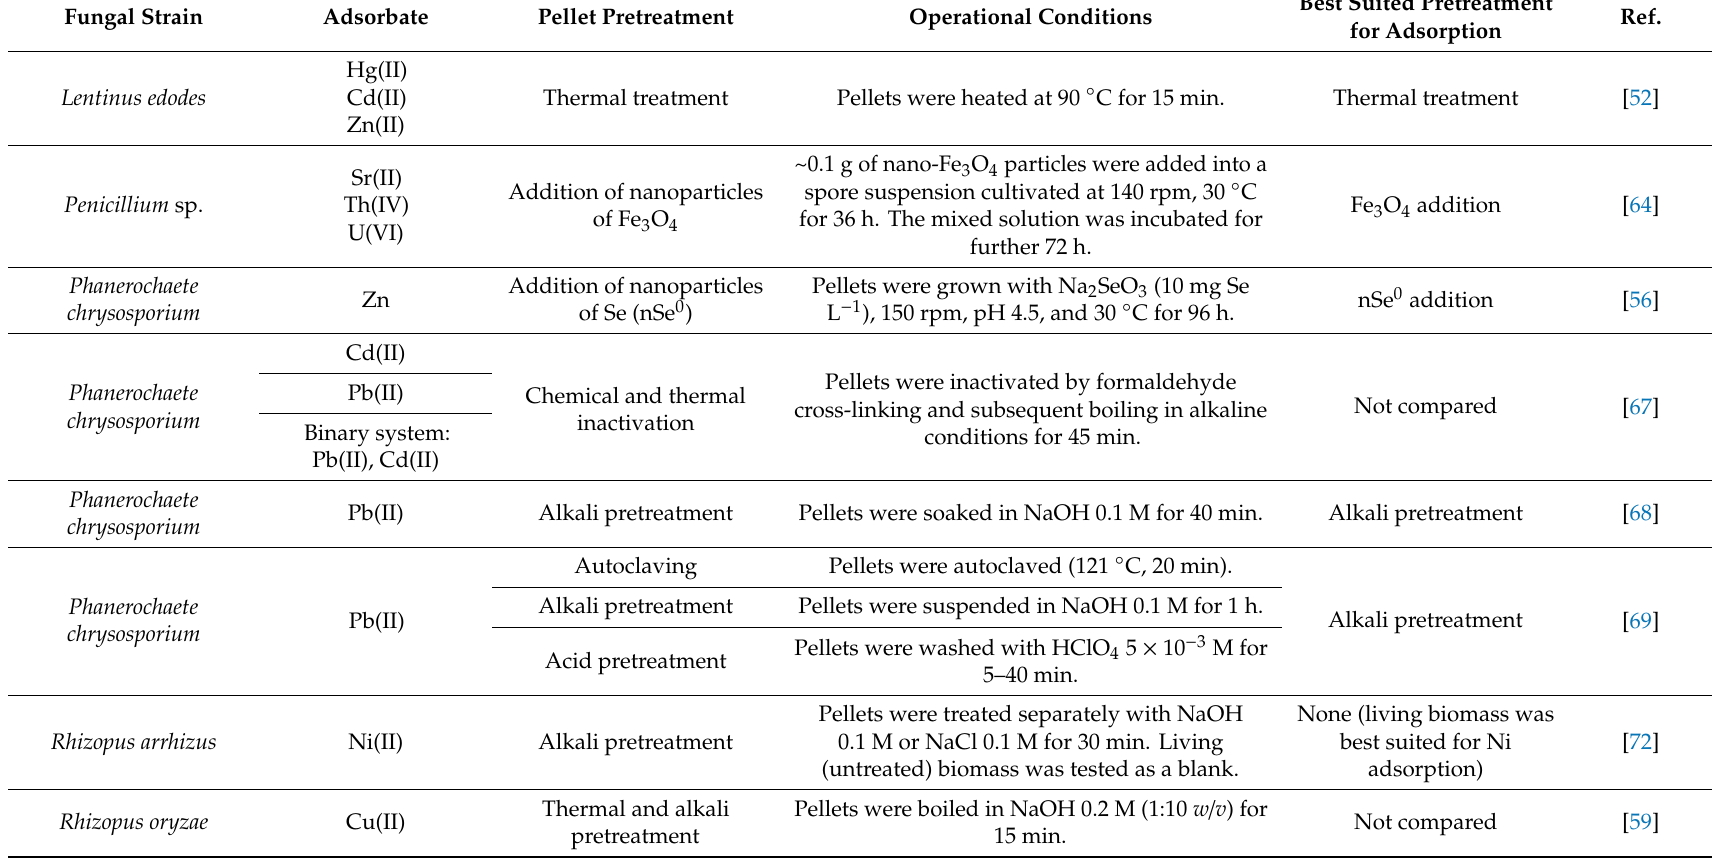
Table 2. Summary of some pretreatments used in metal biosorption